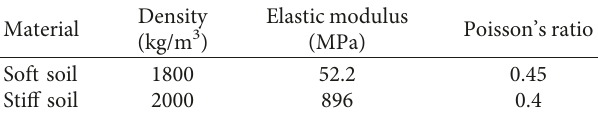
Table 3: The equivalent seismic rigidity of soil